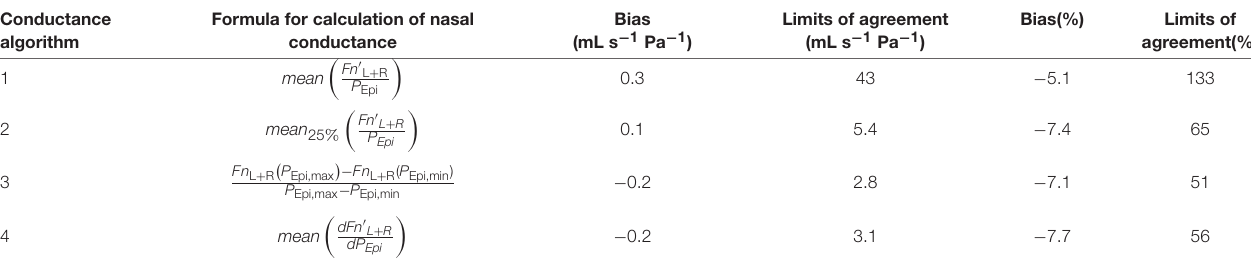
TABLE 1 | Accuracy of nasal pressure-derived conductance obtained by various algorithms according to Bland-Altman a . Conductance Formula for calculation of nasal algorithm conductance